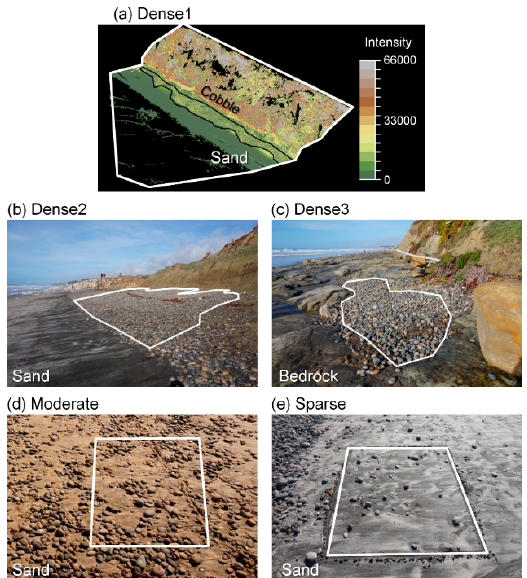
Figure 6. Manually mapped control sites used to test automated cobble mapping. ( a , b ) Dense cobble exposure on sand, ( c ) dense cobble exposure on bedrock, ( d ) moderate cobble exposure on sand, and ( e ) sparse cobble exposure on sand. Areas enclosed by white lines indicate the areas examined, and a black line in 6a encloses dense cobble surface exposures. Points in 6a are colored by intensity.